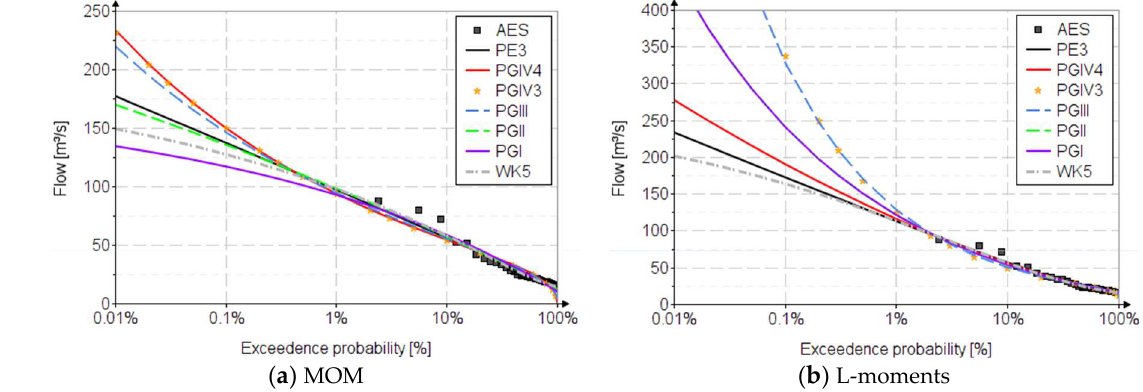
Figure 4. The fitting distributions for AES. Table 9. Parameter values of each distribution for MOM and